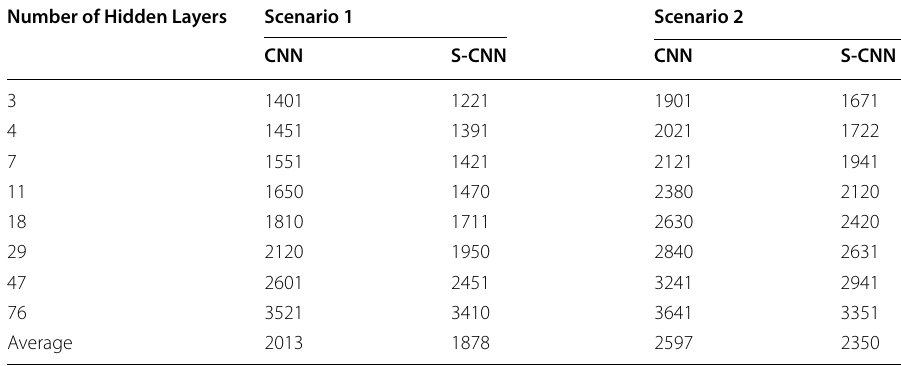
0.57) in all scenarios =